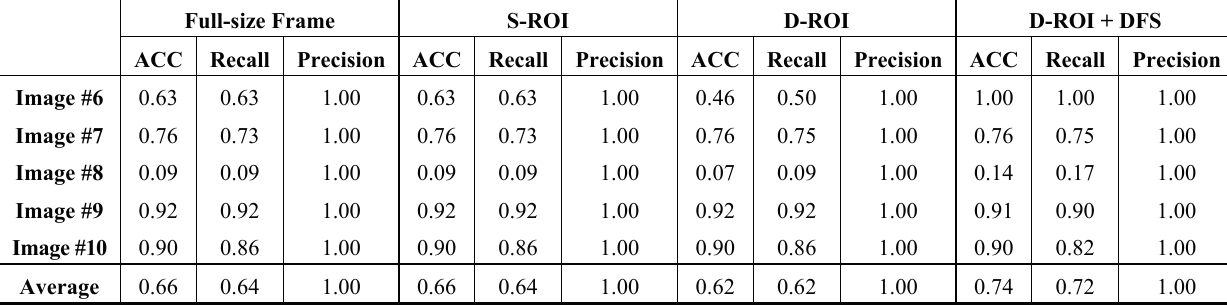
Table 8. Comparison of recognition accuracy, recall, and precision for the proposed methods (license plate